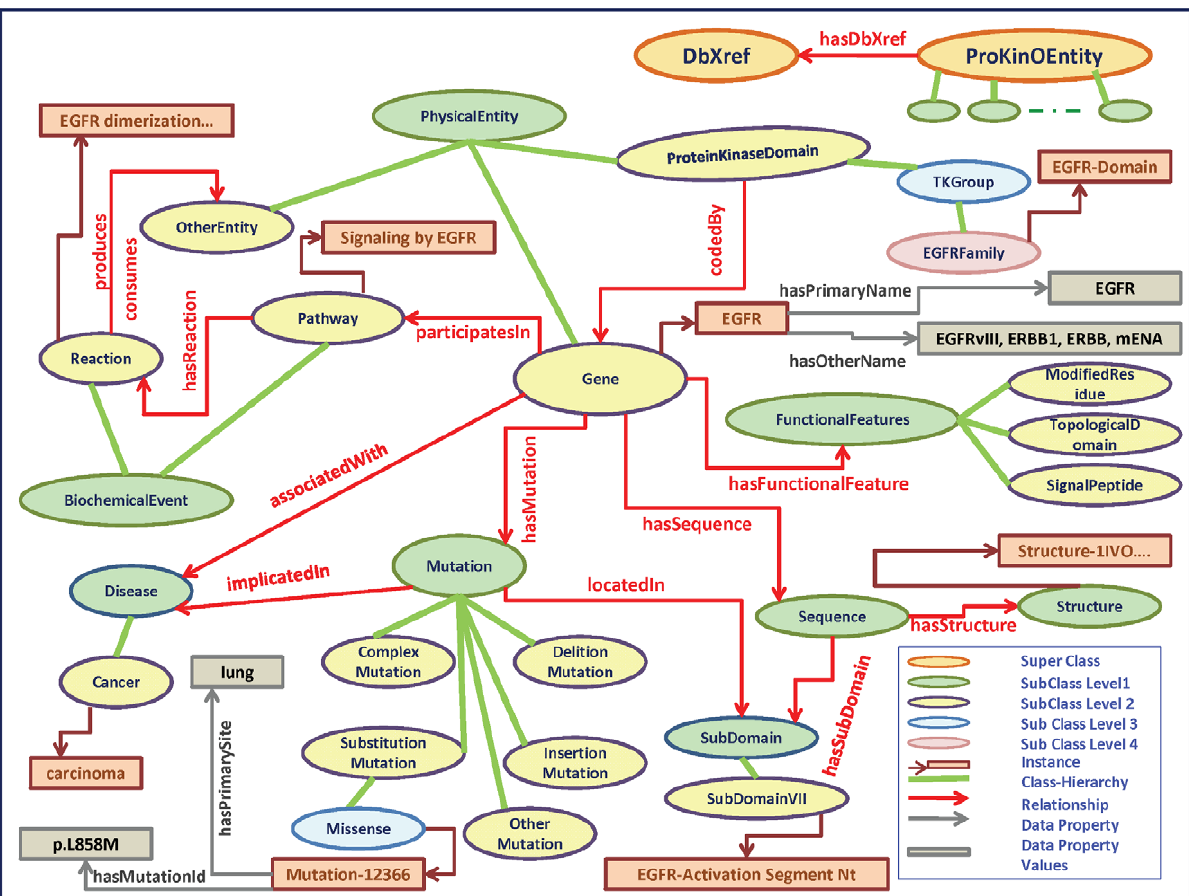
Figure 1. A section of the Protein Kinase Ontology (ProKinO) schema showing key concepts and relationships. The figure shows concepts (classes) organized in a class sub-class hierarchy (shown as ovals). The relationships (object properties) between classes are shown as red colored lines. The internal specifics (data properties) of classes are shown as brown colored lines. The instances of classes are shown as rectangles. The complete ontology schema can be accessed from the ProKinO web site, and also provided as Figure S1.